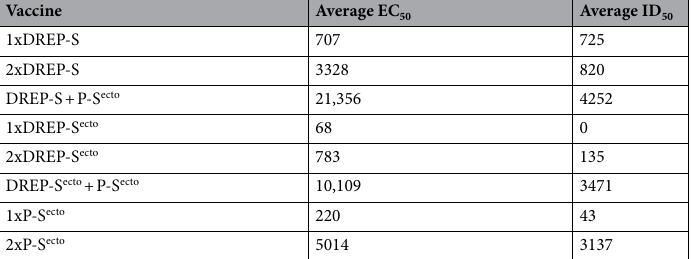
Table 1. Relationship between anti-RBD binding antibody responses (EC 50 ) and neutralizing antibody responses (ID